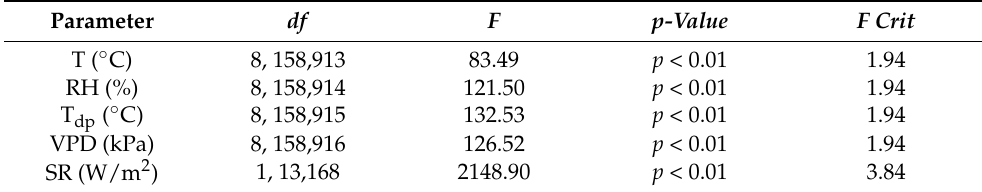
Table 7. ANOVA results for T, RH, Tdp, VPD, SR, and CO 2 distribution in SLG. T: air temperature;